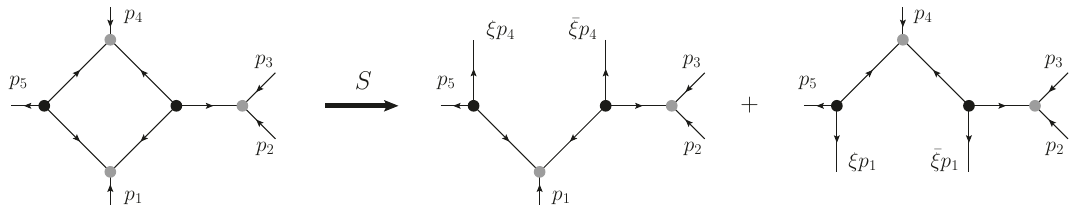
and , see A 1 A 4